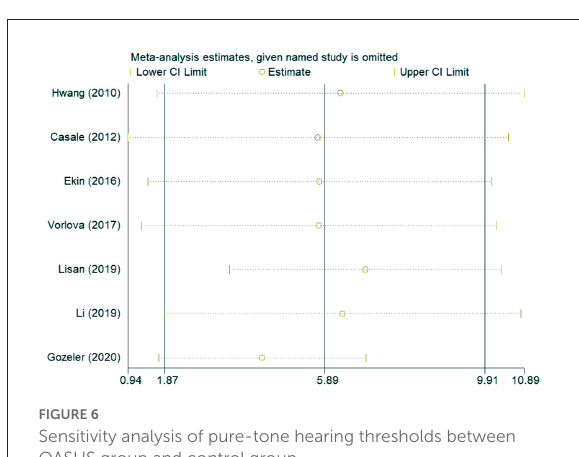
red blood cell aggregation index. Coupled with the